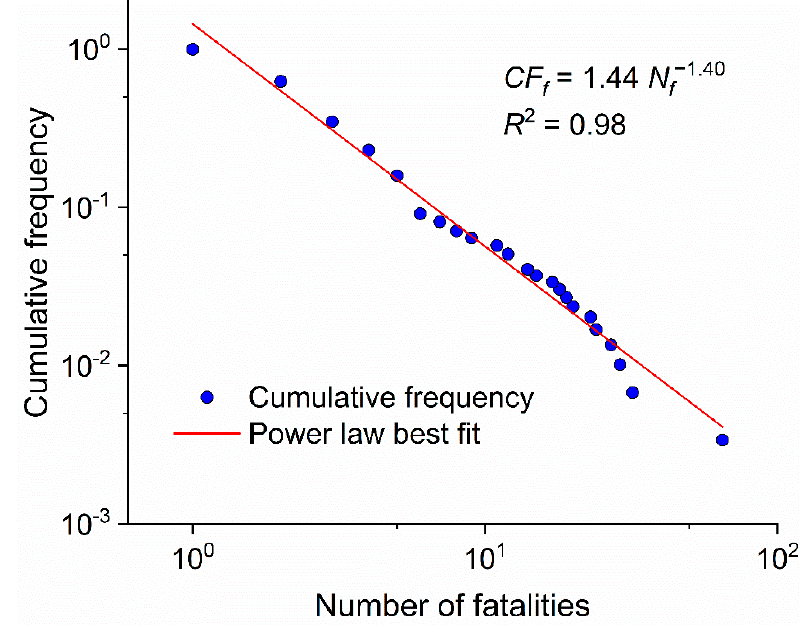
Figure 15. Cumulative frequency of fatality number.